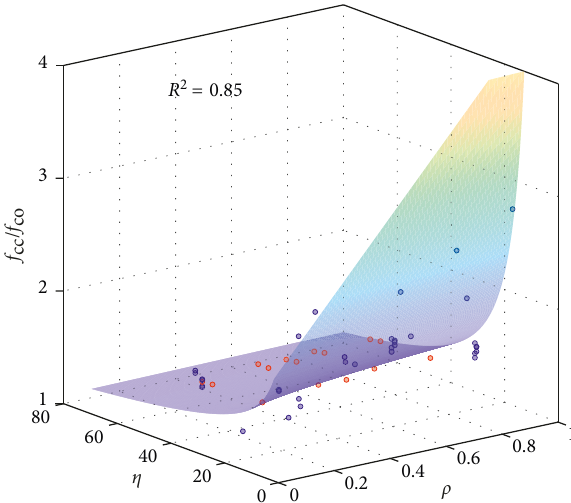
/ f with the cc co